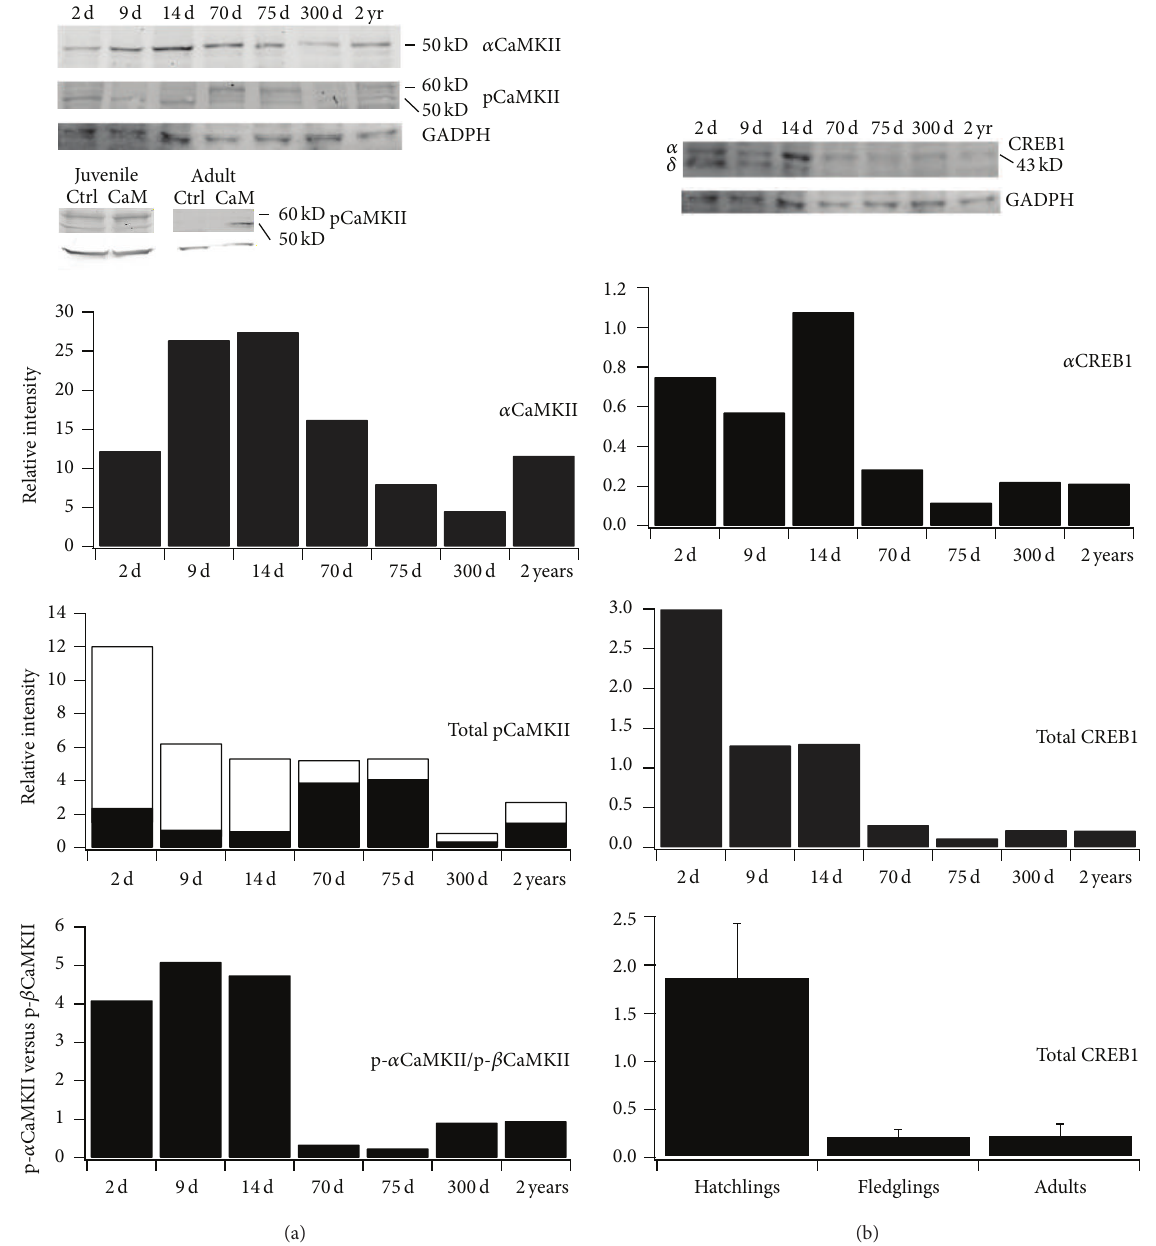
Figure 2: Immunoblotting. Brain homogenates of 7 owls ranging in age from 9 d to 2 yrs were analyzed using antibodies against native ( 𝛼 CaMKII) and phosphorylated (pCaMKII) forms of CaMKII and native CREB1. (a) Top , 𝛼 CaMKII labeled a single band of expected molecular weight, 50kD. pCaMKII labeled two distinct bands, phospho- 𝛼 CaMKII (50 kD) and phospho- 𝛽 CaMKII (60kD). GADPH was usedasloadingcontrol.Proteinsamplesfromasinglejuvenileandsingleadultintheabsence(ctrl)andpresence(CaM)ofcalmodulinconfirm theabilityofthephosphospecificantibodytodetectchangesinphosphorylationstate. Bottom ,normalizedintensitiesfor 𝛼 CaMKII,pCaMKII, and their ratio. For total pCaMKII, black bars correspond to phospho- 𝛽 CaMKII and open bars to phospho- 𝛼 CaMKII. (b) Top , CREB1 labeled a single band (in most samples) of expected molecular weight, 43 kD, corresponding to the alpha isoform of CREB1. Hatchlings also expressed lower levels of the delta isoform. Bottom , normalized intensities for 𝛼 CREB1, total CREB1, and total CREB1 binned for hatchlings (2, 9, and 14d), fledglings (70 and 75 d), and adults (300d and 2